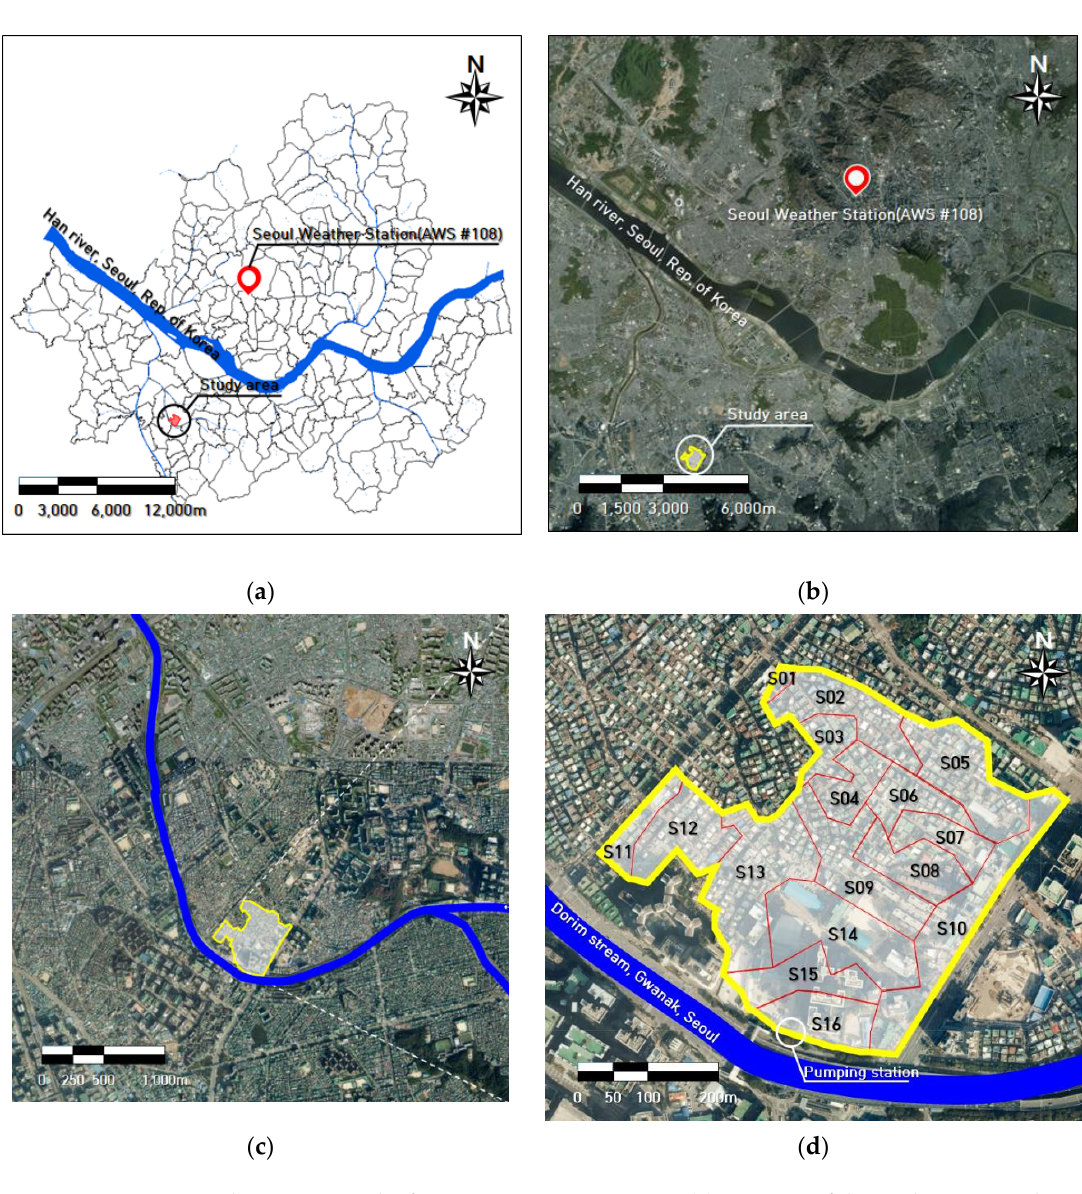
Figure 5. Basin and sewer network of Daerim2 pumping station. ( a ) GIS Map of the study area-Seoul, Rep. of Korea; ( b ) Map of the Seoul Weather Station (AWS #108); ( c ) Google Map Image of Daerim 2